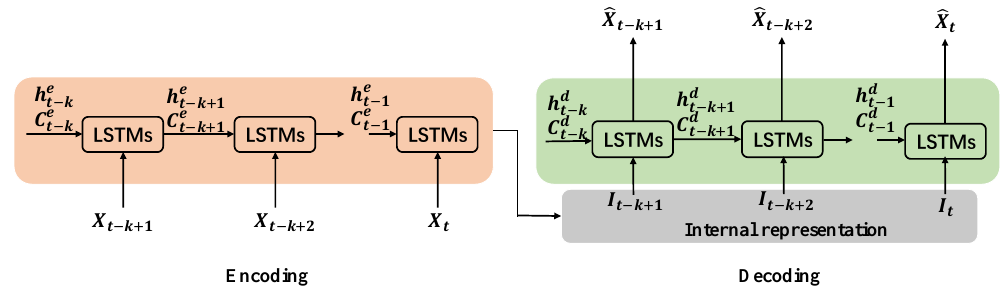
Figure 4. Architecture of the LSTM-AE.